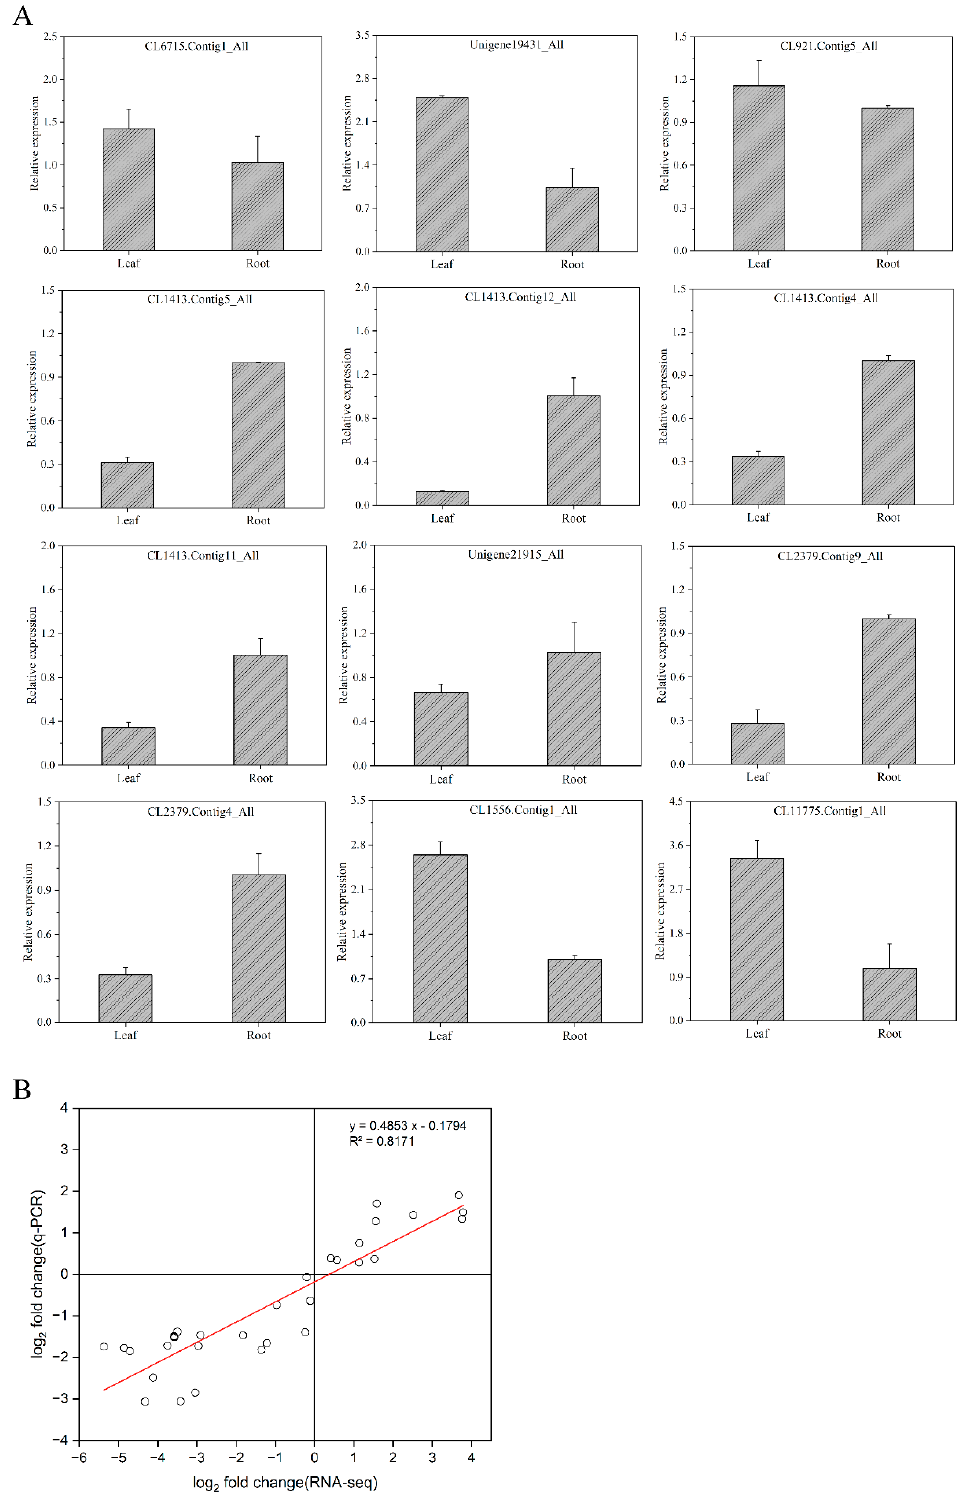
Figure 8. Validation of the differentially expressed genes. ( A ) Relative expressions of flavonoid- synthesis-related genes; ( B ) Correlation between RNA-seq and relative gene expression (the x-axis represents the log 2 fold change value of the RNA-seq results, and the y-axis represents the log 2 fold change value of the relative expression of related genes; all data were collected from three biological replicates and three technical replicates).